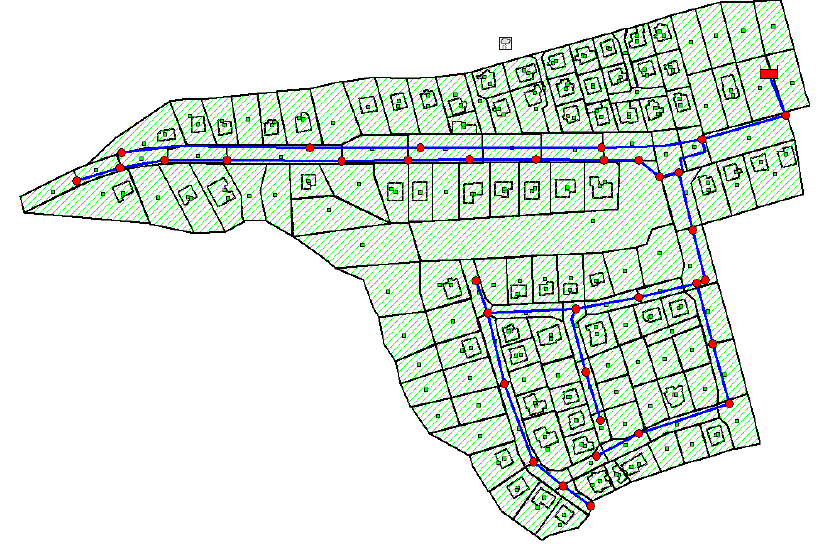
Figure 8. Hydrodynamic model of the study catchment area.